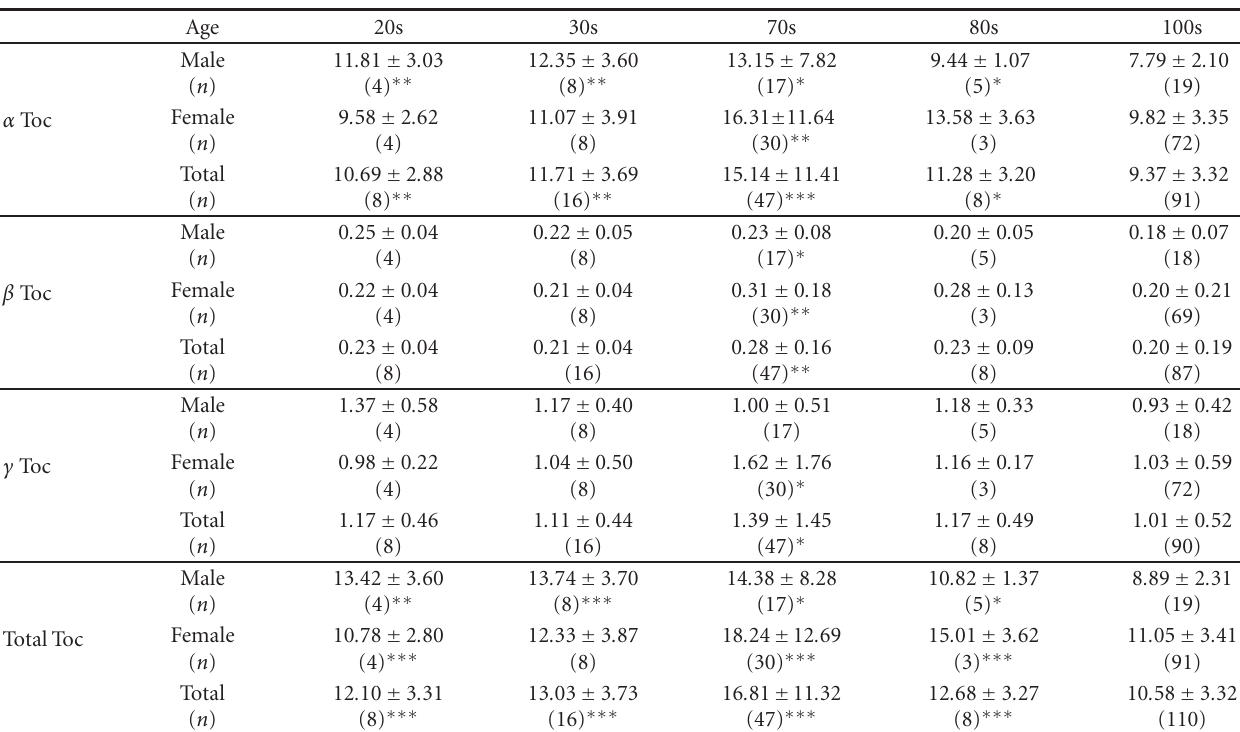
Table 2: Mean plasma tocopherol (total and subtype) by age group ( μ